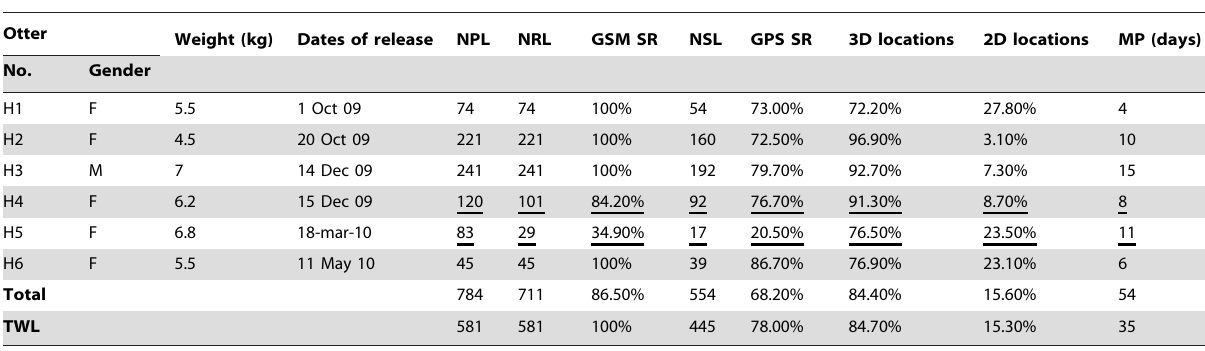
Table 6. Performance of GPS devices fitted on wild otters in Southern Portugal, in 2009.